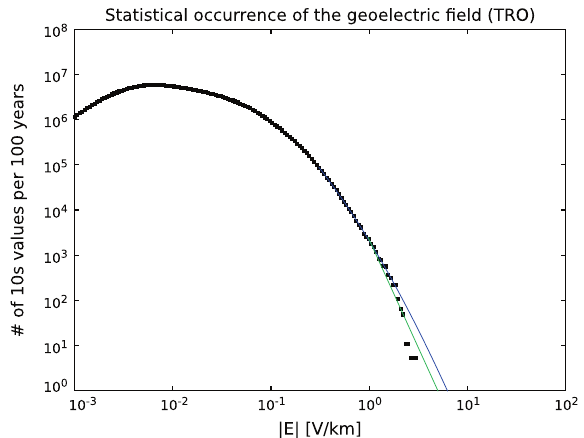
Fig. 10. Statistical occurrence of 10-s electric field values per 100 years at Tromsø. Coloured lines correspond to two different extrapolation methods explained in the text.